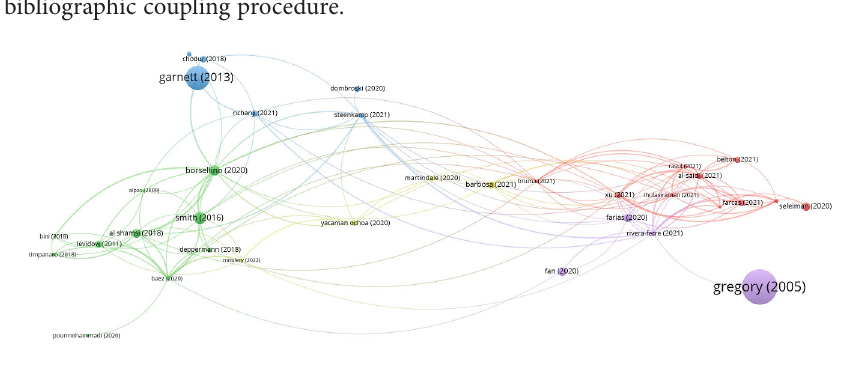
Figure 2. Bibliographic coupling of research in the food security and short supply chain area,